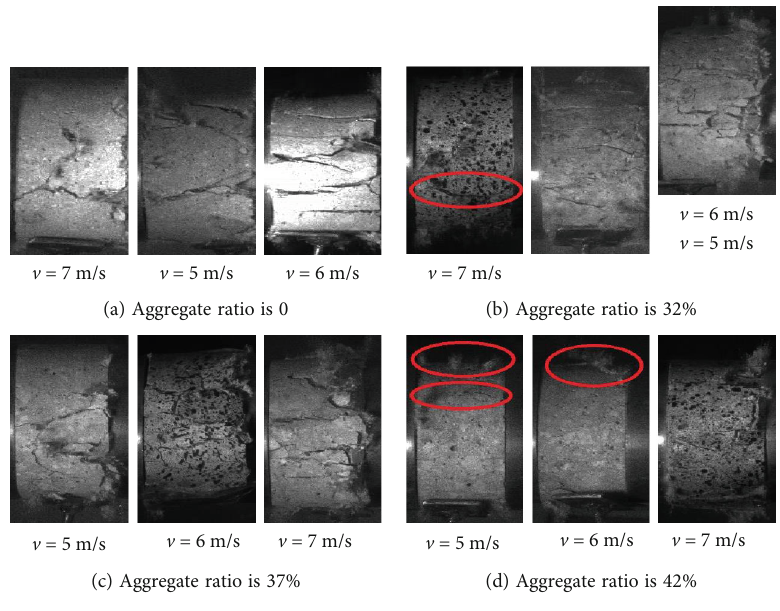
Figure 3: Form of crack penetration time of concrete